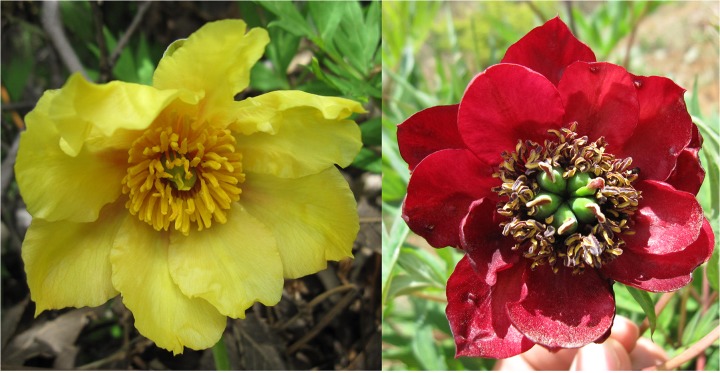
Fully open flowers of individuals selected for sequencing.A, yellow flowered individual; B, purple-red flowered individual.